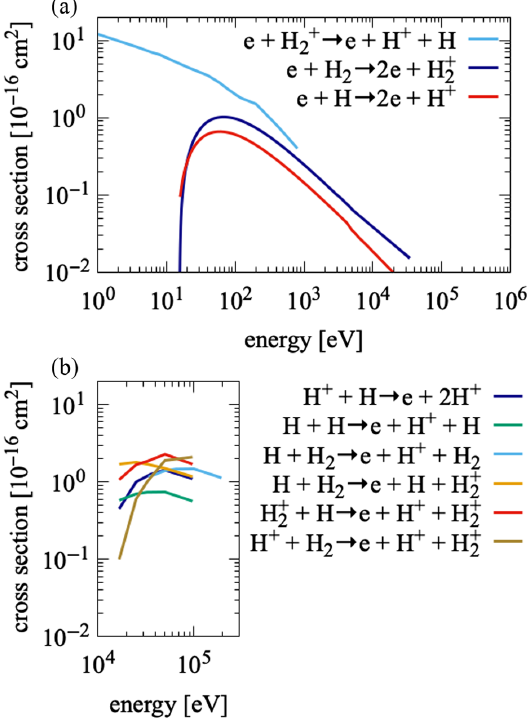
FIG. 2. The cross sections used in the breakdown model for (a) electron impact ionization and detachment [75,76,82] and (b) hydrogen impact ionization [78].